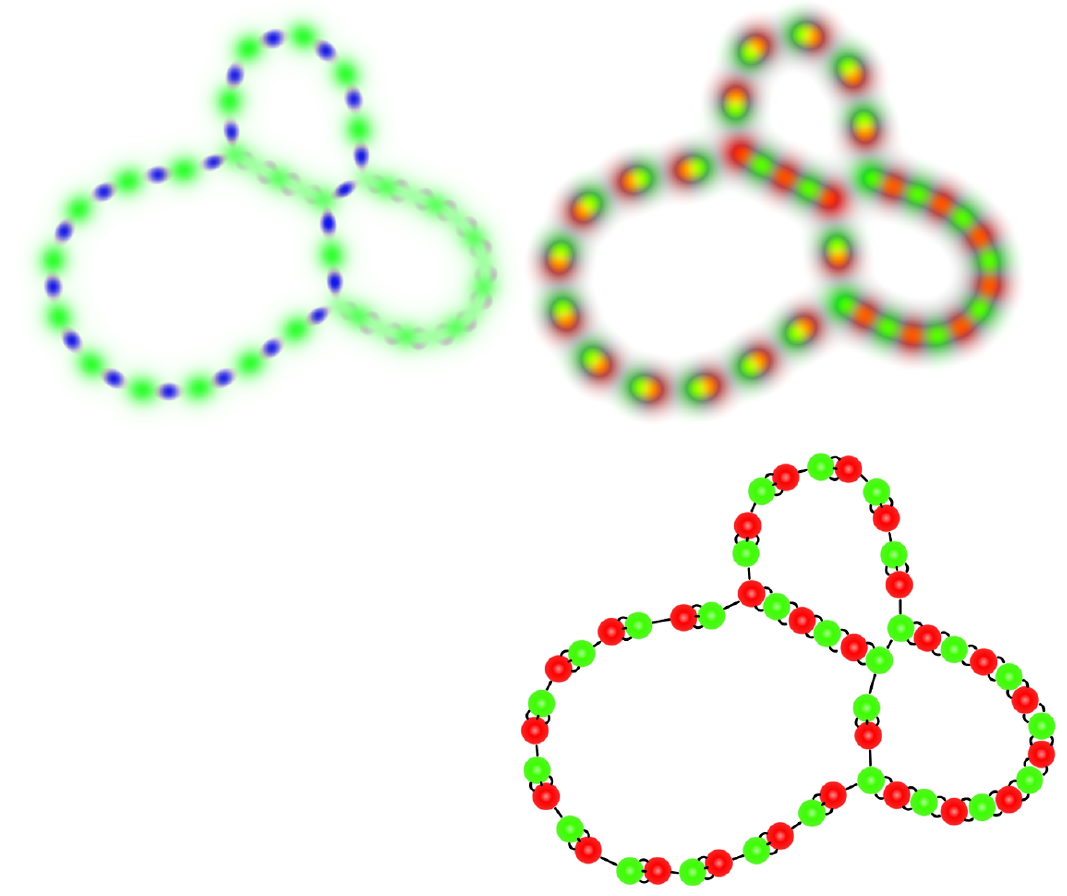
Figure 14 : ( Q 1 ; Q 2 ) = (4 ; 4) nonminimal vortex ring network. The (cid:12)gure contains 3 elements from left to right and then down: an energy density plot, a (cid:12)eld density plot and a sketch of how the red and green vortices are interconnected. The (cid:12)rst two plots are made using the coloring scheme of (cid:12)gure